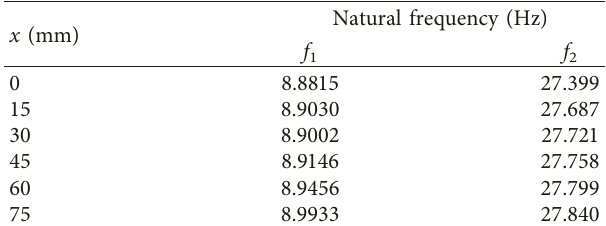
Figure 6: Variations of the natural frequencies of a rectangular plate supposed differently with various h . Table 4: Influence of cutout location on the first two frequencies of clamped-free